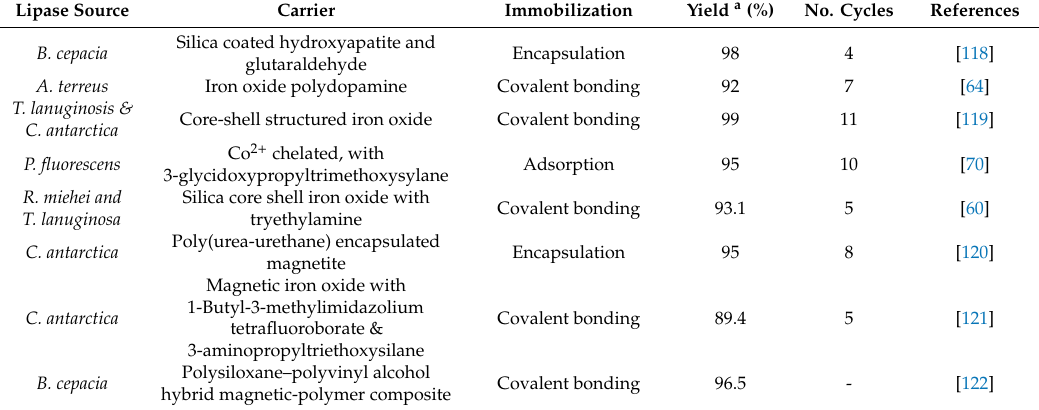
Table 4. Biodiesel production with various immobilized lipases using magnetic nanoparticles as carriers. Lipase